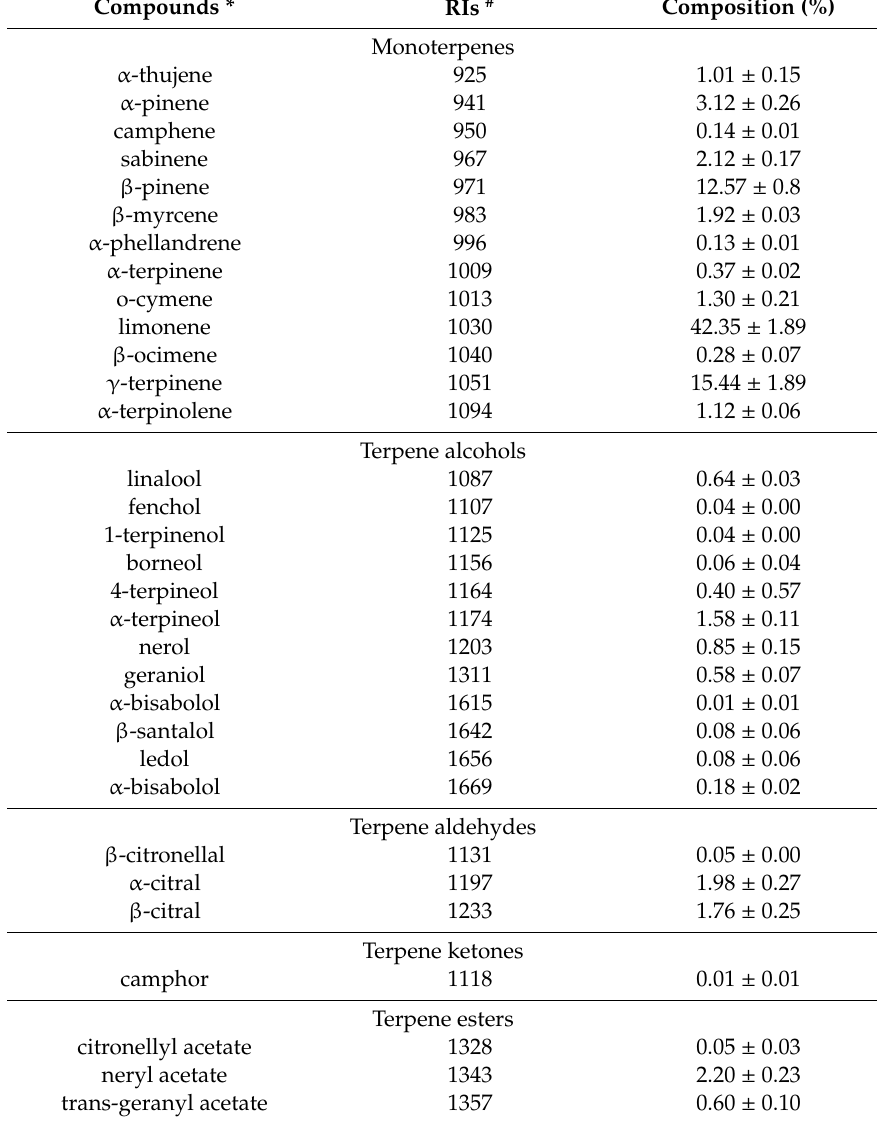
Table 2. Composition of essential oil of lime